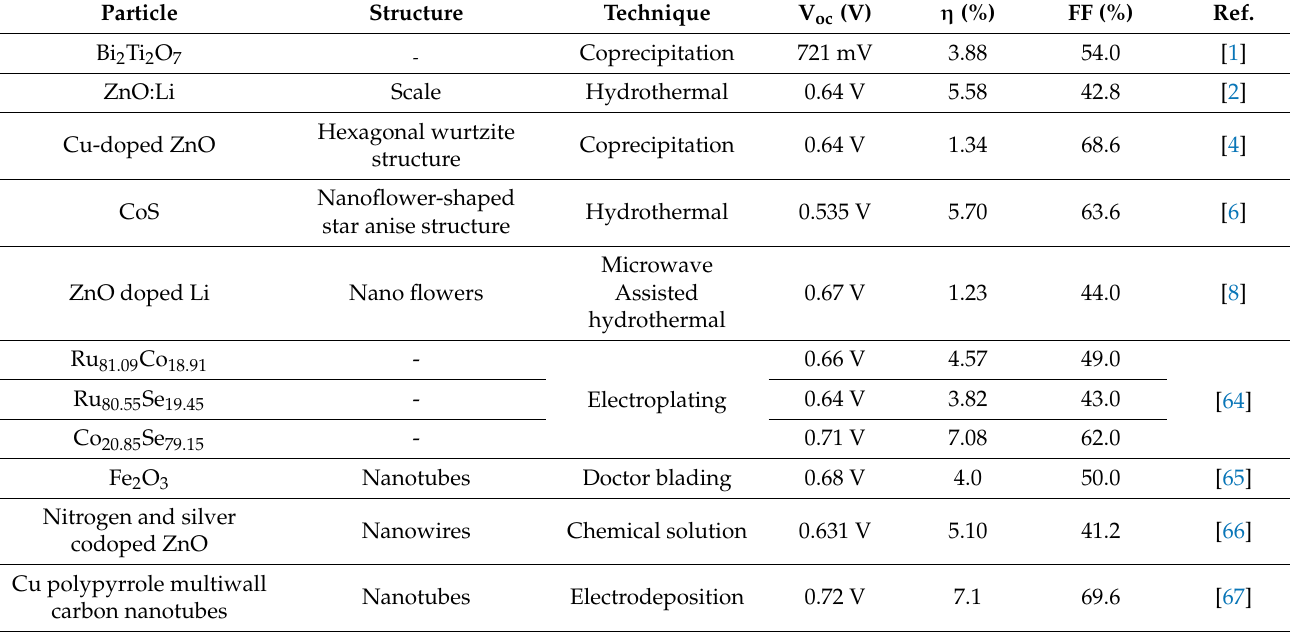
Table 6. Nonconventional nanostructures in